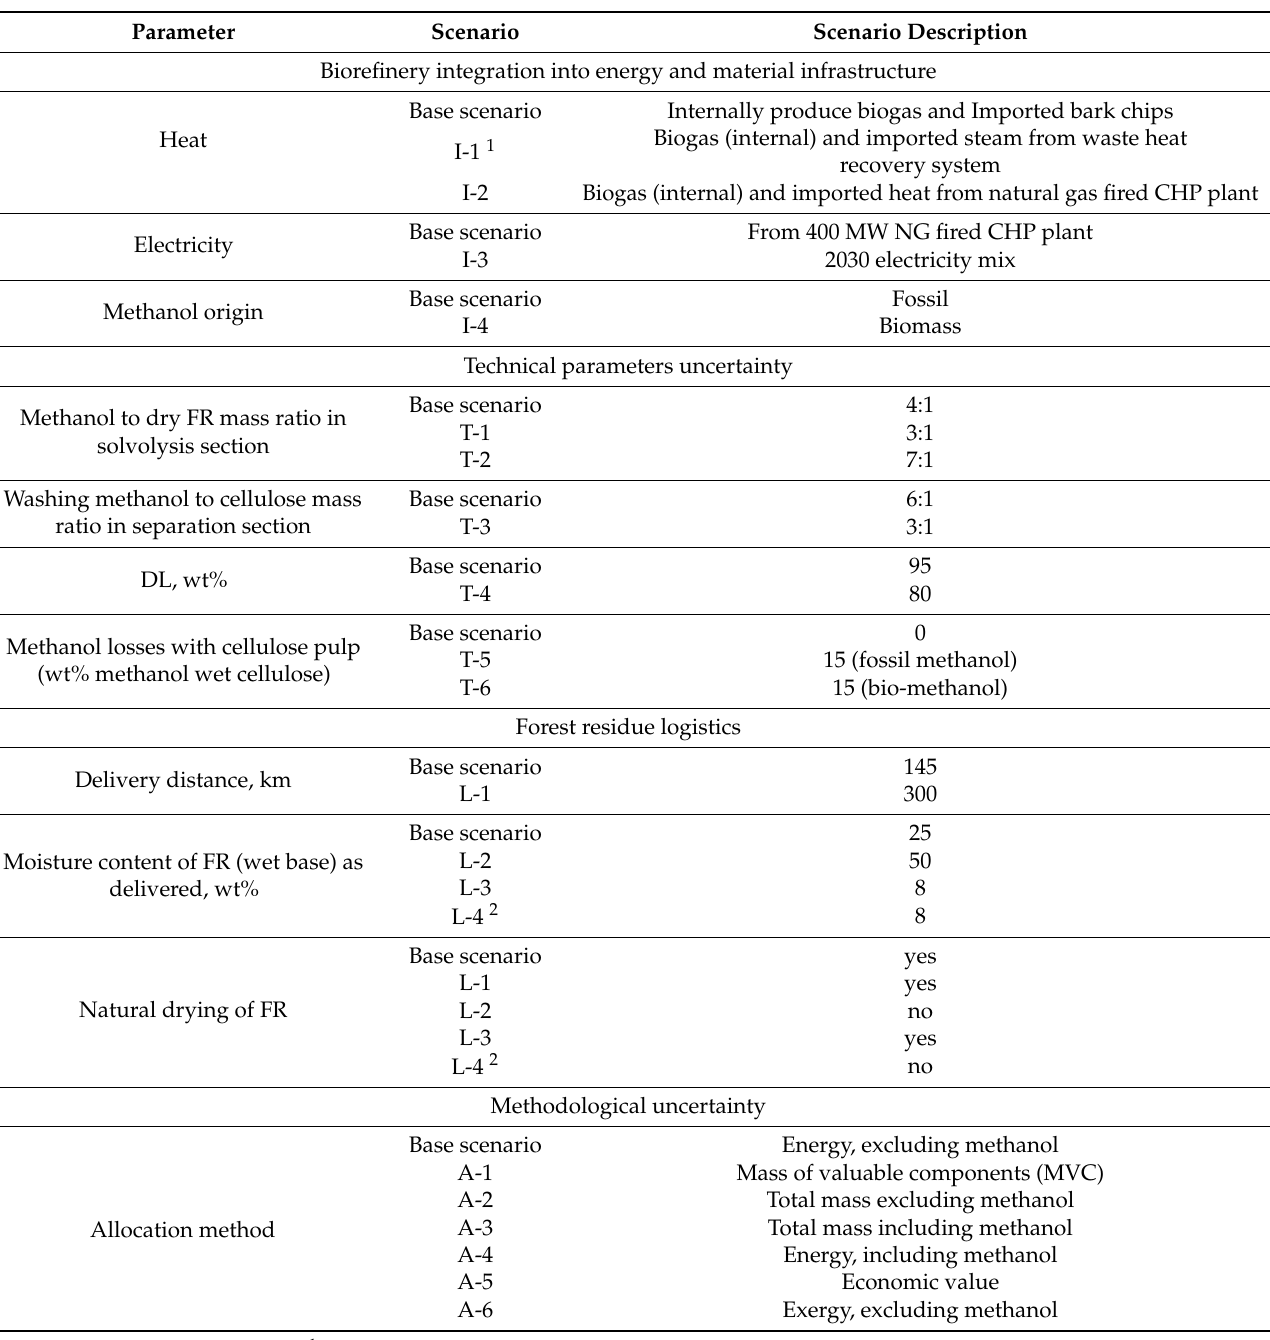
Table 2. Scenarios description and inputs to a single point sensitivity